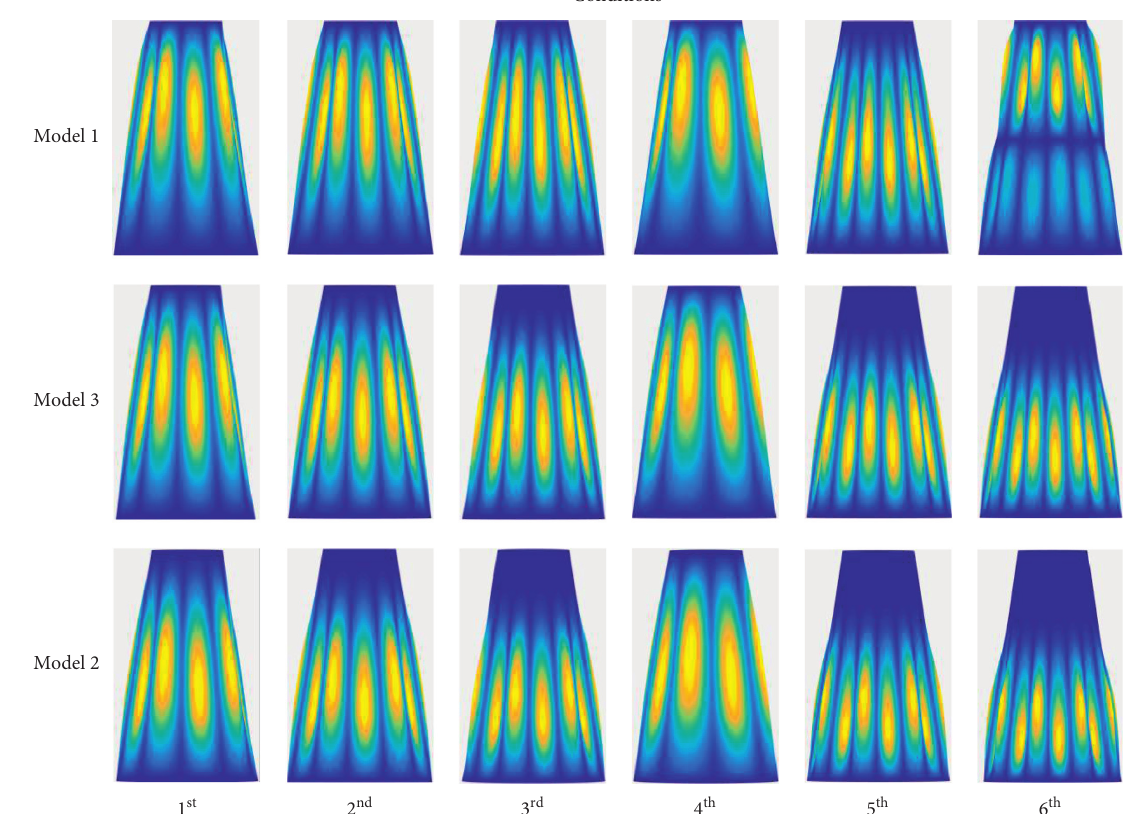
Figure 13: Mode shapes of stepped joined conical shell under C–C boundary condition.